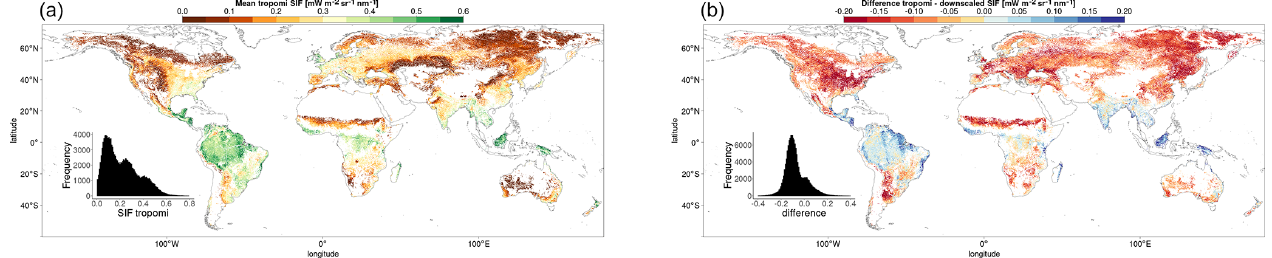
Figure A5. (a) The mean TROPOMI SIF in the 2020 growing season. (b) The difference (TROPOMI − downscaled) between mean TROPOMI SIF (2020) and mean downscaled SIF (2007–2014).